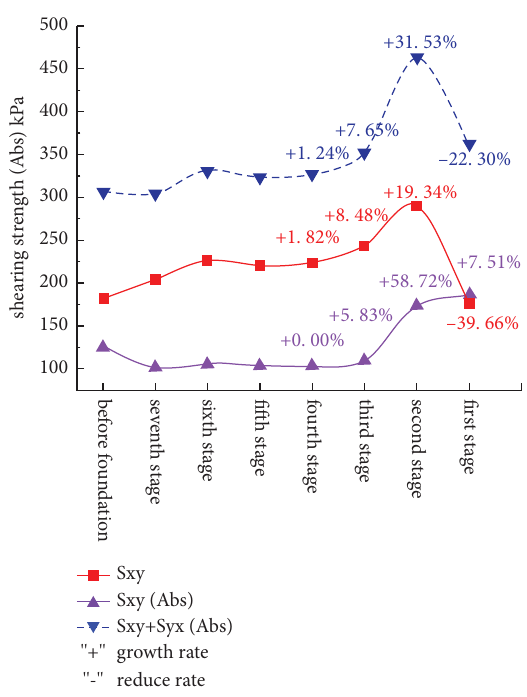
Figure 3: Variation curve of maximum shear stress of slope ex- cavation at all